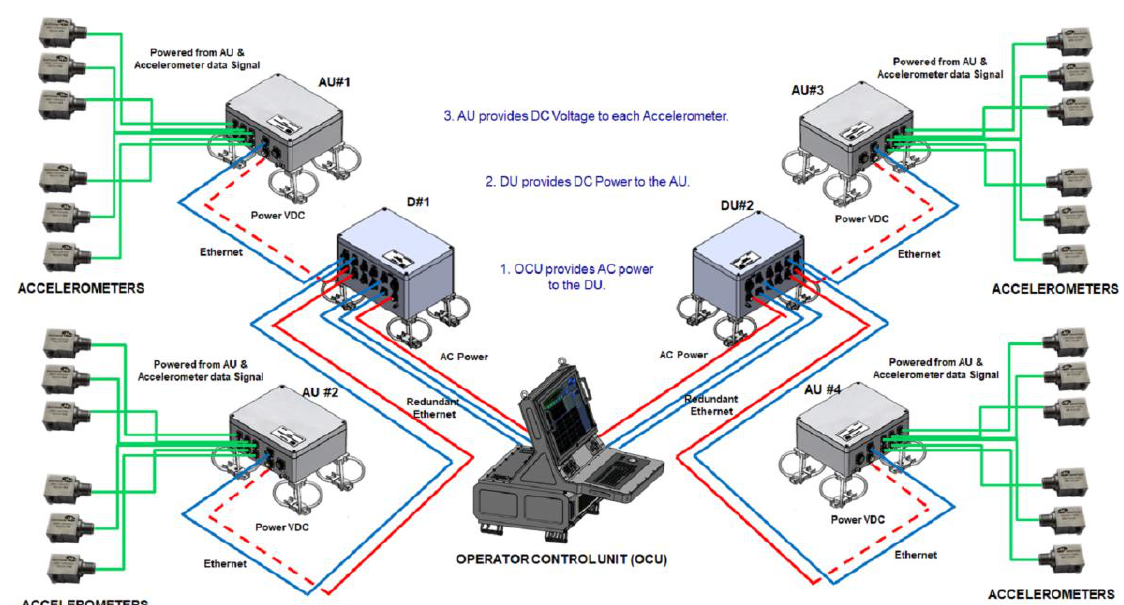
Figure 2. General architecture of the Vibration Control Systems (VCS) and main units. Image property of Sociedad Anónima de Electronica Submarina S.M.E. (SAES).